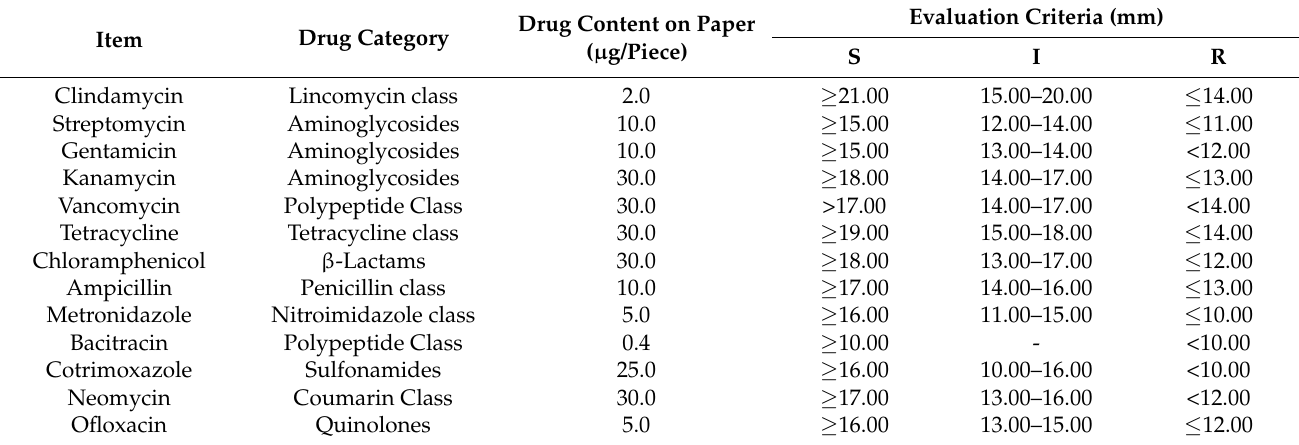
Table 2. Drug resistance judgment standard